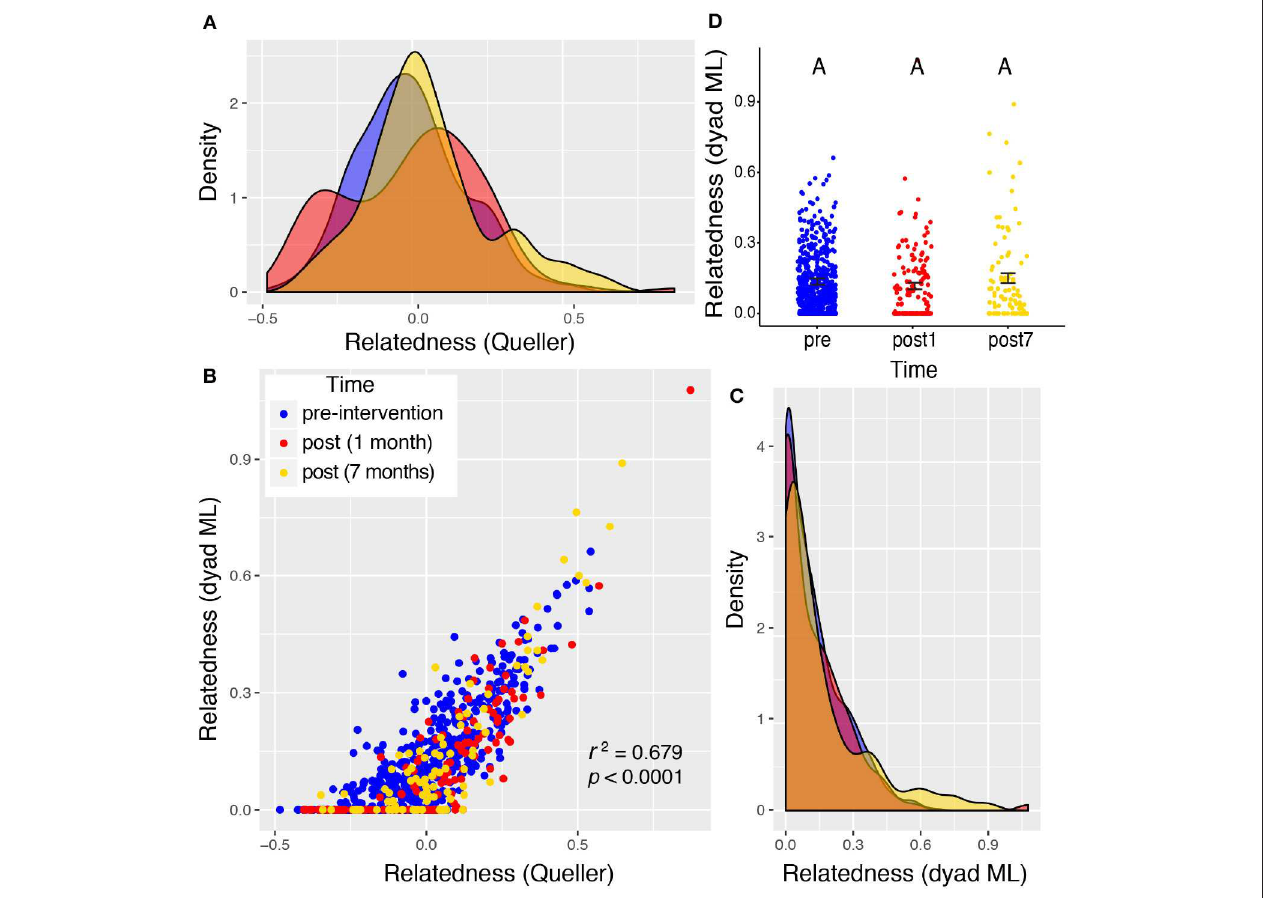
FIGURE 4 | Valley 1: two very different measures of relatedness suggest that there was no significant change in the distribution of relatedness between individual rats sampled pre- and post-eradication in Valley 1, represented by density distributions below (A,C) . The Queller-Goodnight relatedness coefficient can take negative values (A) , while the Milligan dyad maximum likelihood (dyad ML) metric is bounded by zero and one (C) . The two metrics are tightly correlated in this data set (B) . A Kruskal–Wallis test was used to determine if the distribution of relatedness values differed among the three time points sampled around the 2015 eradication campaign (D) . The upper-case letters above the points in panel (D) are all the same, indicating that there is no significant difference between the distributions of relatedness pre- and post-eradication. Black bars represent the mean ±